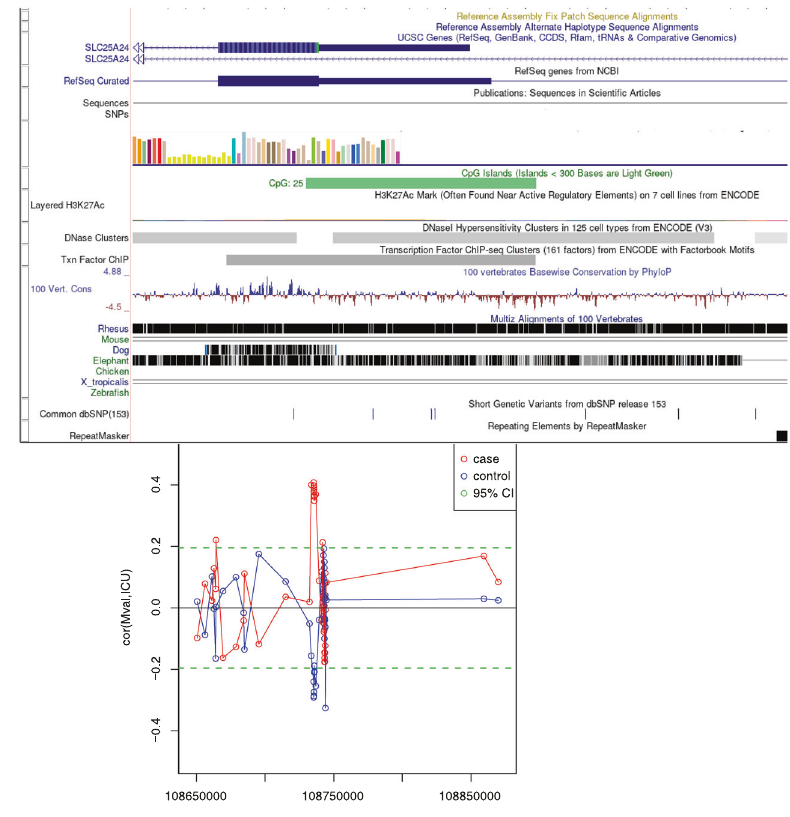
Fig. 1 Genomic Location of the Chr1. Differentially Methylated Region. (Top) UCSC Genome Browser Illustration showing stacked annotation tracks beneath the genomic coordinates of the region which showed differential methylation according to the CD × CU traits interaction (from the hg19 human reference gene); (bottom) a scatter plot of this differentially methylated region highlighting the opposite relationship between methylation and level of CU traits in CD cases vs. control